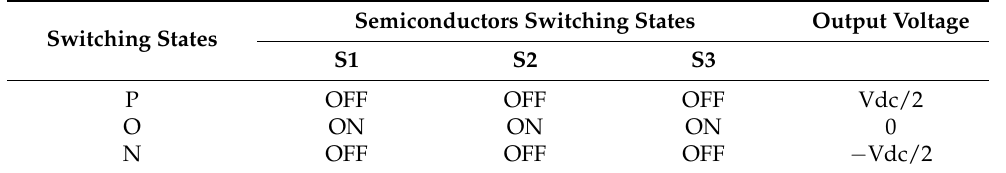
Table 1. Vienna converter switching states.